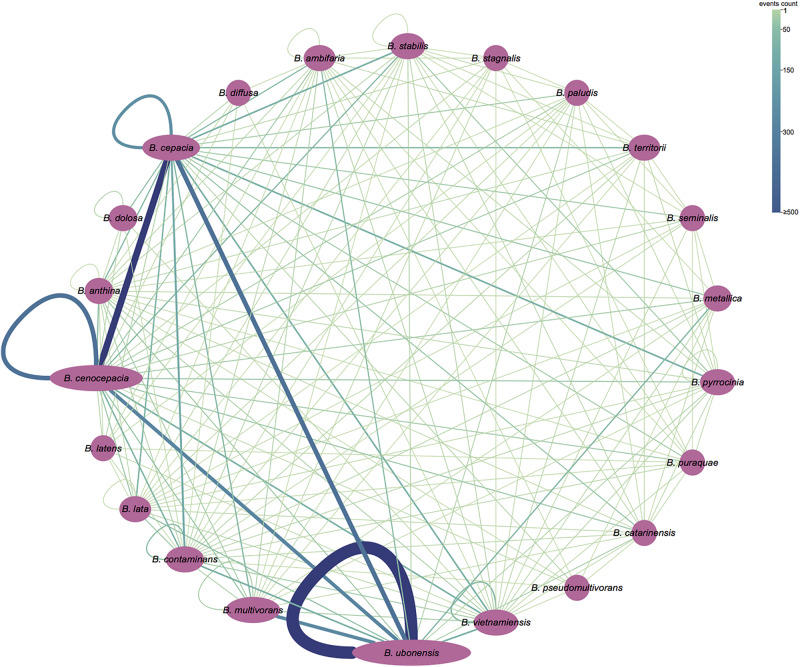
Partition of recombination events (“inner” fragments) detected by GENECONV. The purple ellipse represents the bacterial species in Bcc, and the area of ellipse corresponds to its genome numbers. A line between two ellipses means recombination events between the strains of the corresponding species; a loop line means the recombination events between strains of the same species. The number of recombination events is shown by the width and the color of the line. The figure was visualized and colored by Cytoscape version 3.7.1.